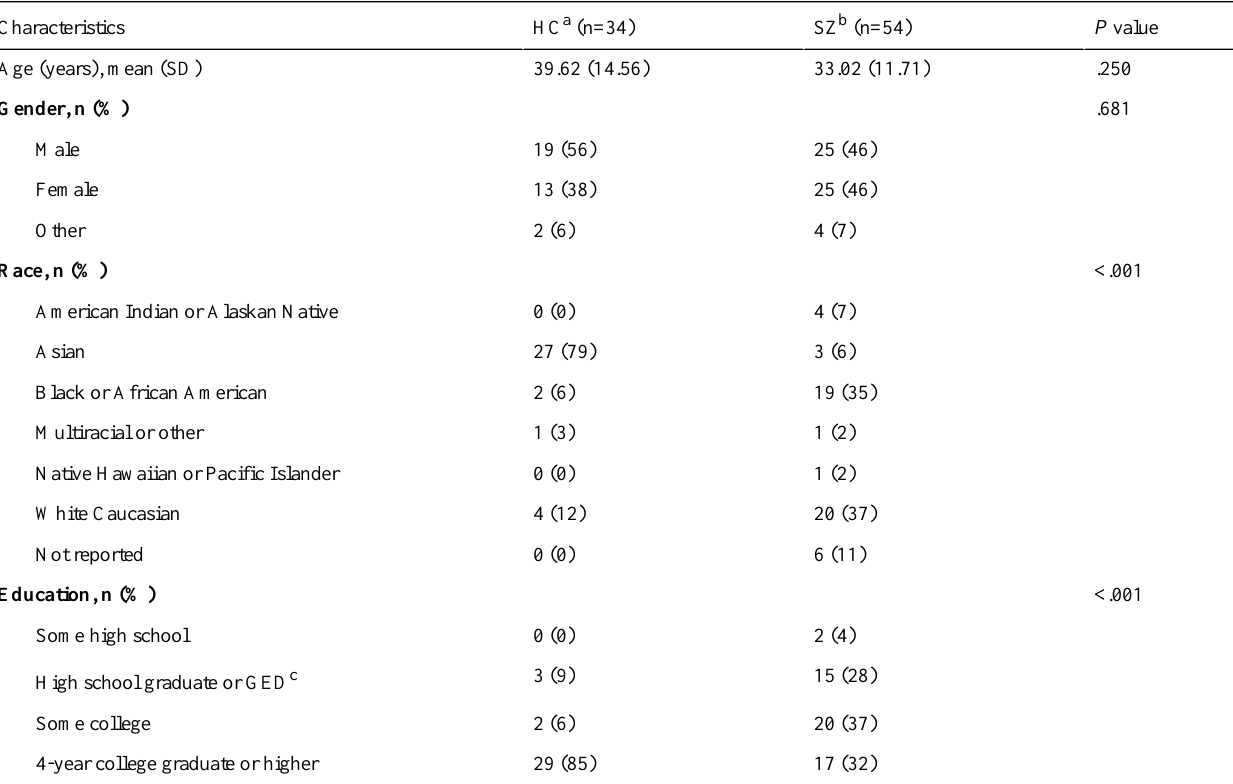
Table 1. Demographic characteristics of 88 smartphone-owning participants from the greater Boston area.